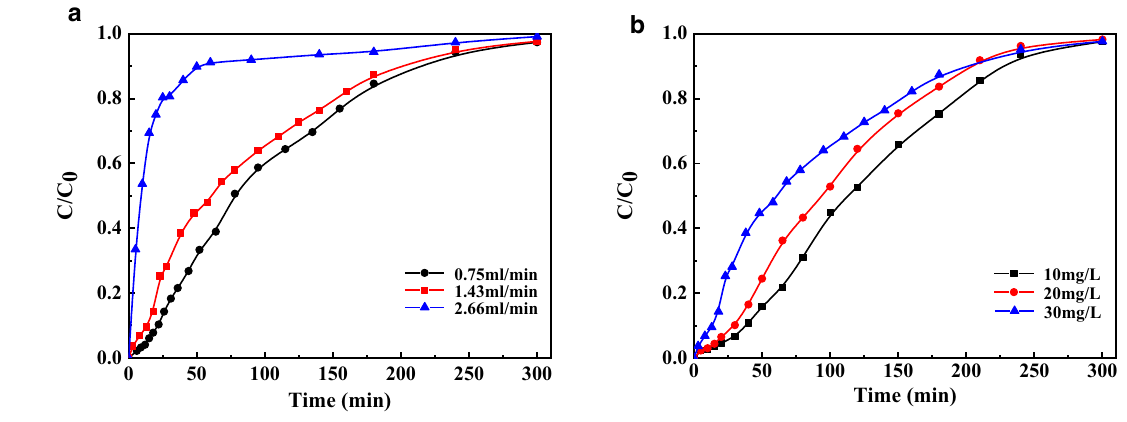
Fig. 11 Effect of feed flow rate a and Pb 2 + initial concentration b on dynamic adsorption for Pb2 +